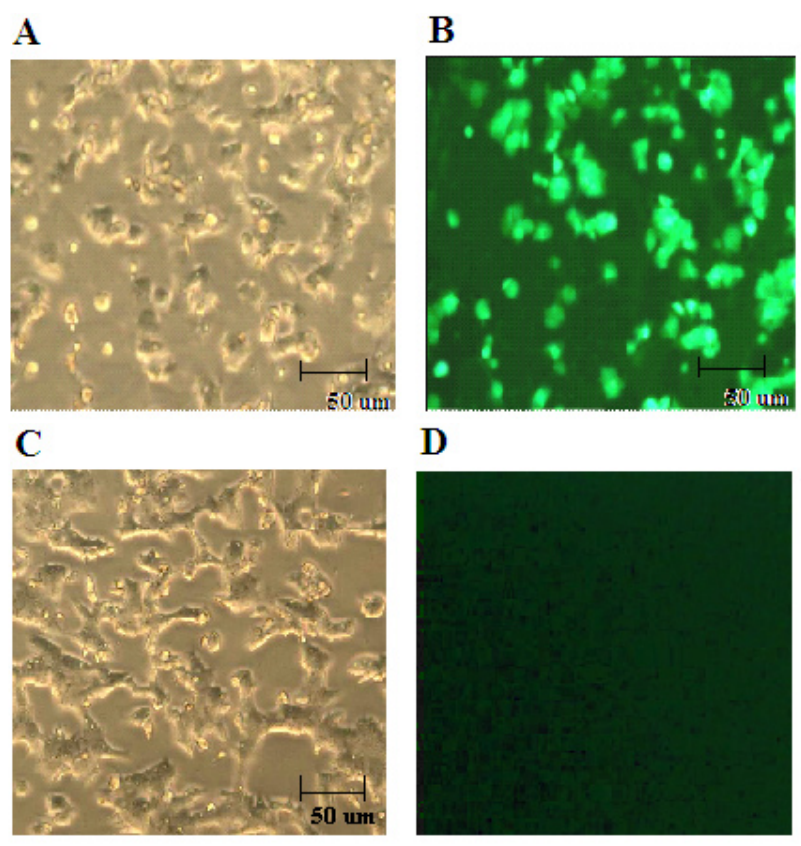
Figure 1. Micrographs of HT-29 cells infected with recombinant lentiviruses. After being in- fected with the recombinant lentiviruses carrying the reporter gene GFP, the transfected cells expressed GFP proteins and could be observed under a fluorescence microscope. The results indicated that 85% HT-29 cells were transfected with the recombinant lentiviruses. A and C, Light microscopy; B and D, fluorescence microscopy. Magnification bars: 50